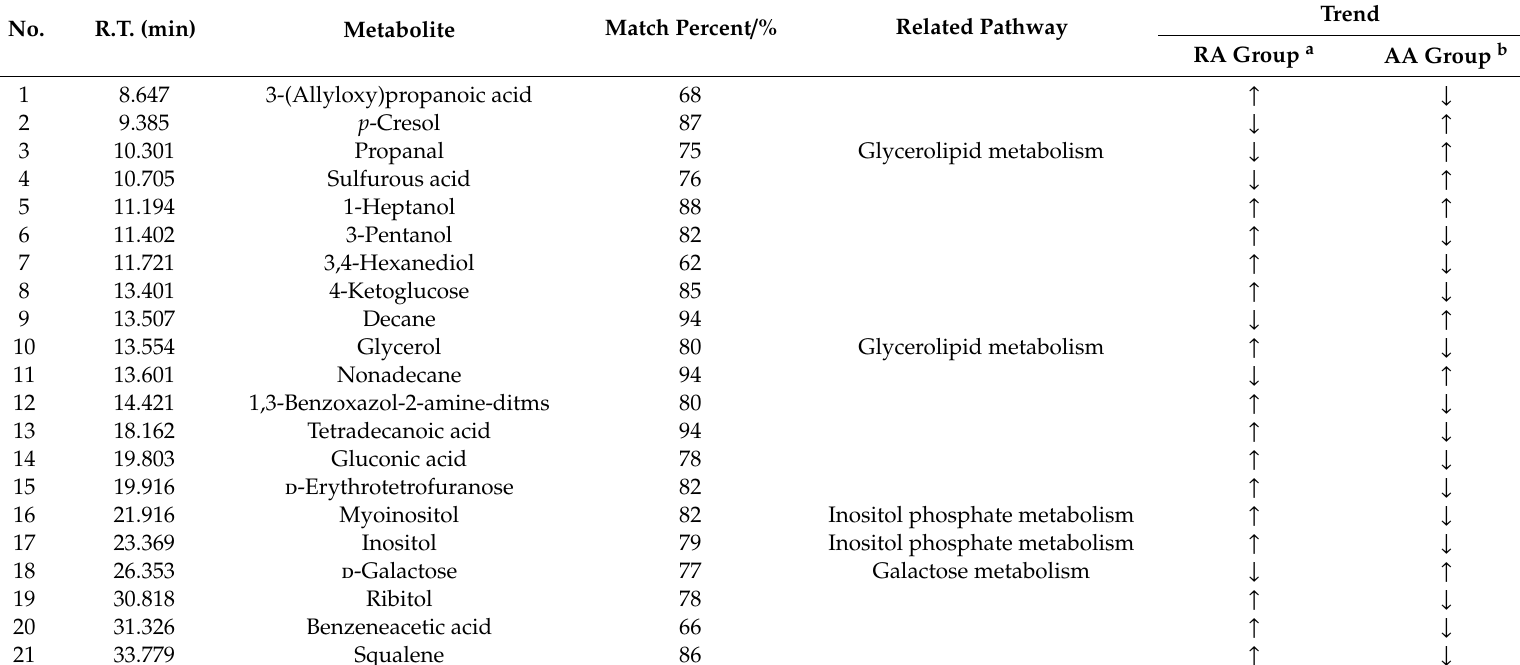
Table 1. Di ff erential metabolites were detected by GC / MS and their metabolic